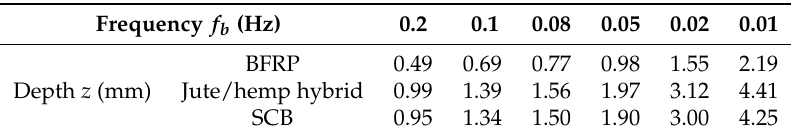
Table 7. Relationship between modulated frequency f b and depth z